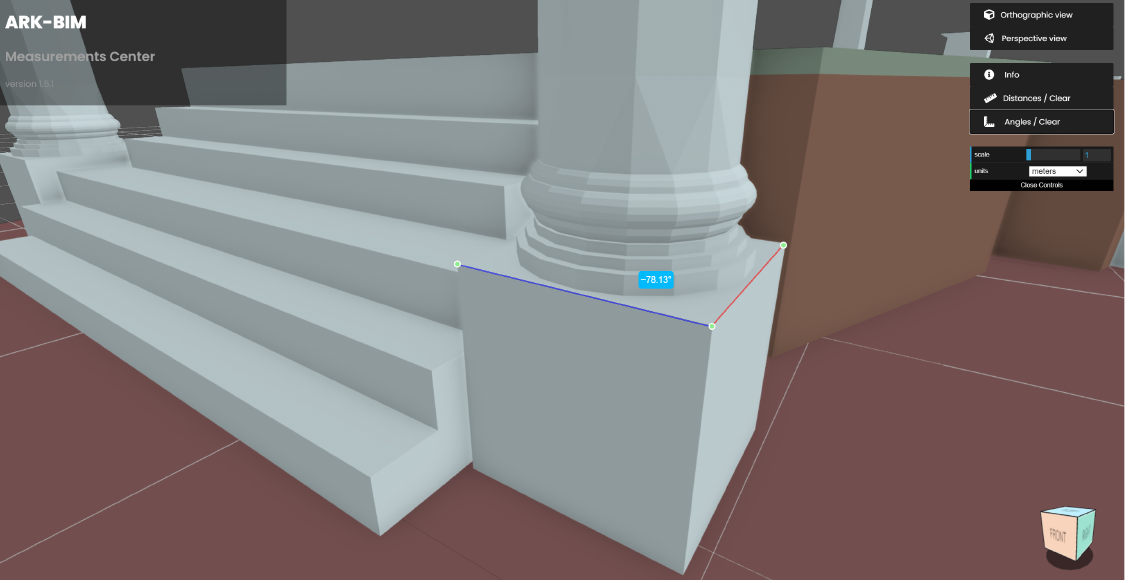
Figure 19. ARK-BIM (version 1.5.1): Measurement Centre plugin, sample of angle measurements.